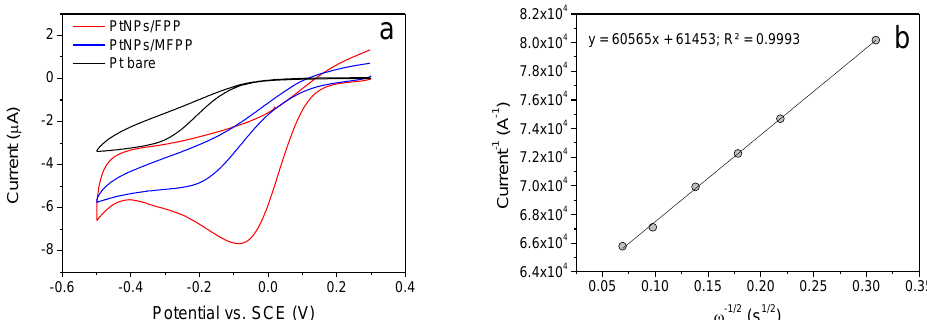
Figure 6. ( a ) Cyclic voltammograms of a bare Pt electrode, PtNPs/MFPP and PtNPs/FPP modified electrodes (Γ 5 × 10 –10 mol Fc cm –2 thickness film) in an oxygen saturated (24 °C) phosphate buffer (pH = 7.0)/NaClO 4 (0.1 m) solution; scan rate: 5 mV s –1 . ( b ) Koutecky–Levich plot for the PtNPs/FPP electrodes the same solution (average values of at least five elec- trodes).